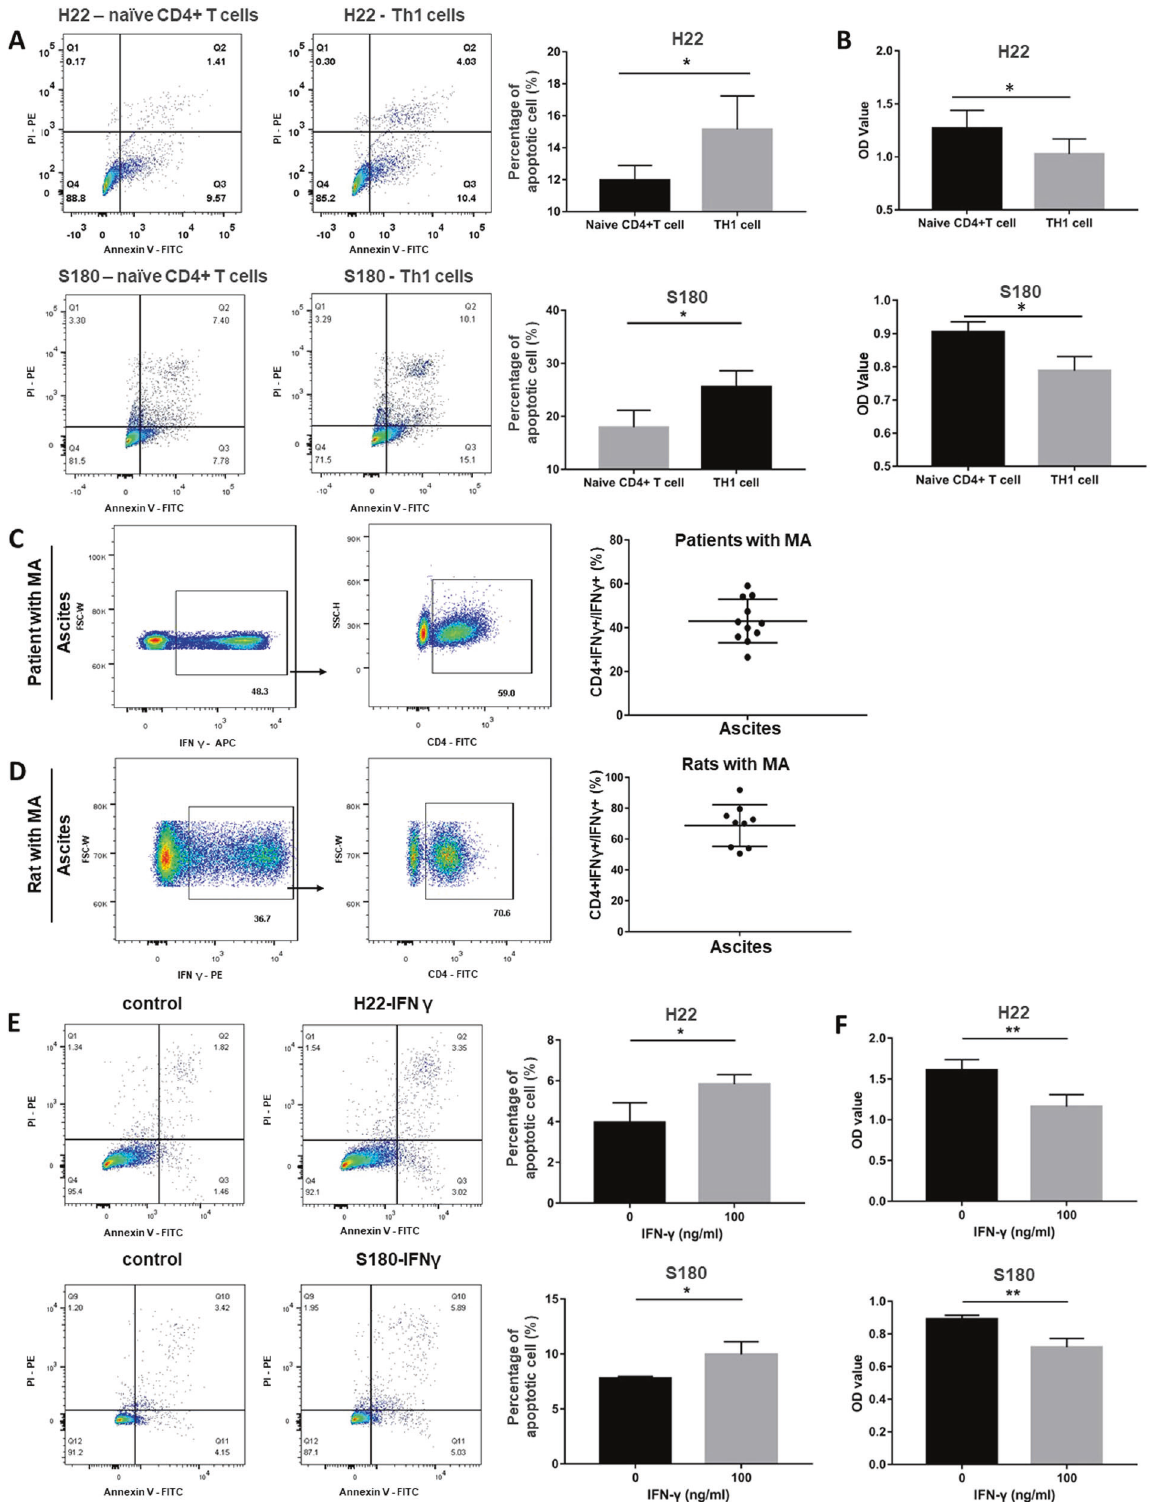
determined in vitro. Naive CD4 + T cells were puri fi ed from mouse spleen instead of malignant ascites since it is dif fi cult to obtain suf fi cient number of naïve T cells from malignant ascites. Then, naive T cells were differentiated into Th1 cells in the presence of Th1 conditions [13]. Our results showed the purity of naïve CD4